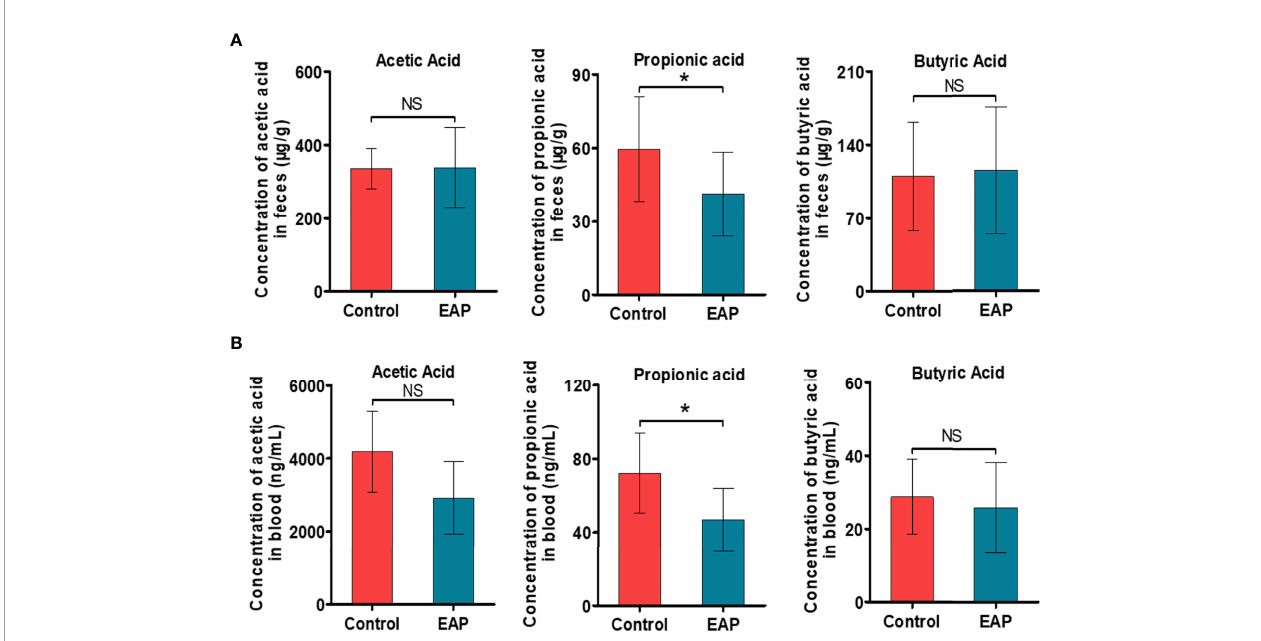
FIGURE 4 | Detection of the absolute concentrations of SCFAs, including acetic acid, propionic acid, and butyric acid, in control and EAP mice. (A) The absolute concentrations of several common SCFAs (acetic acid, propionic acid, and butyric acid) in feces from control and EAP mice. (B) The absolute concentrations of acetic acid, propionic acid, and butyric acid in serum from control and EAP mice. Data are representative of three independent experiments. n = 6 – 10/group; * p < 0.05; NS, not signi fi cant; EAP, experimental autoimmune prostatitis; SCFAs, short-chain fatty